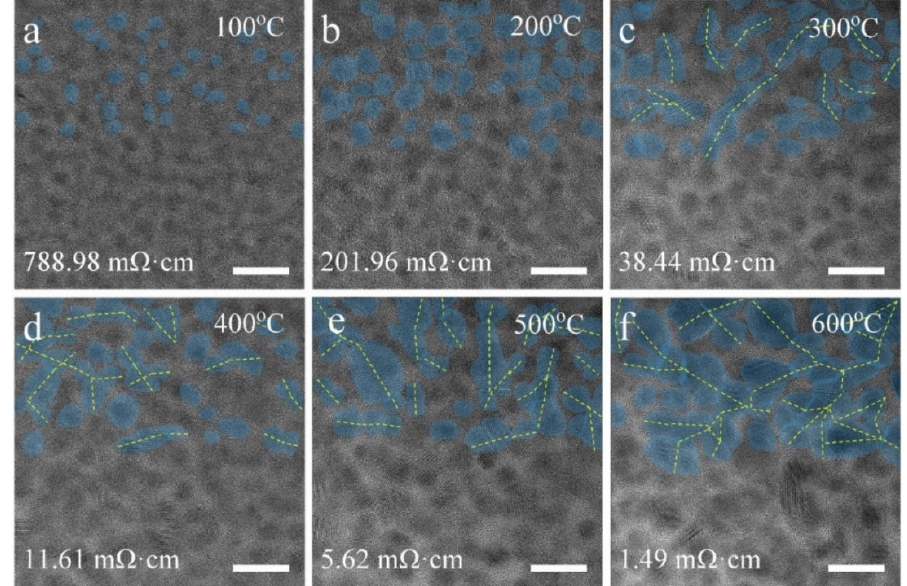
Figure 2. HREM images under different temperatures with their corresponding resistivity values of the Pt interconnector characterized by in situ heating and biasing in TEM together, revealing the gradual growth of Pt grains and the formation of the possible Pt conductive pathways. ( a ) 100 ◦ C, ( b ) 200 ◦ C,